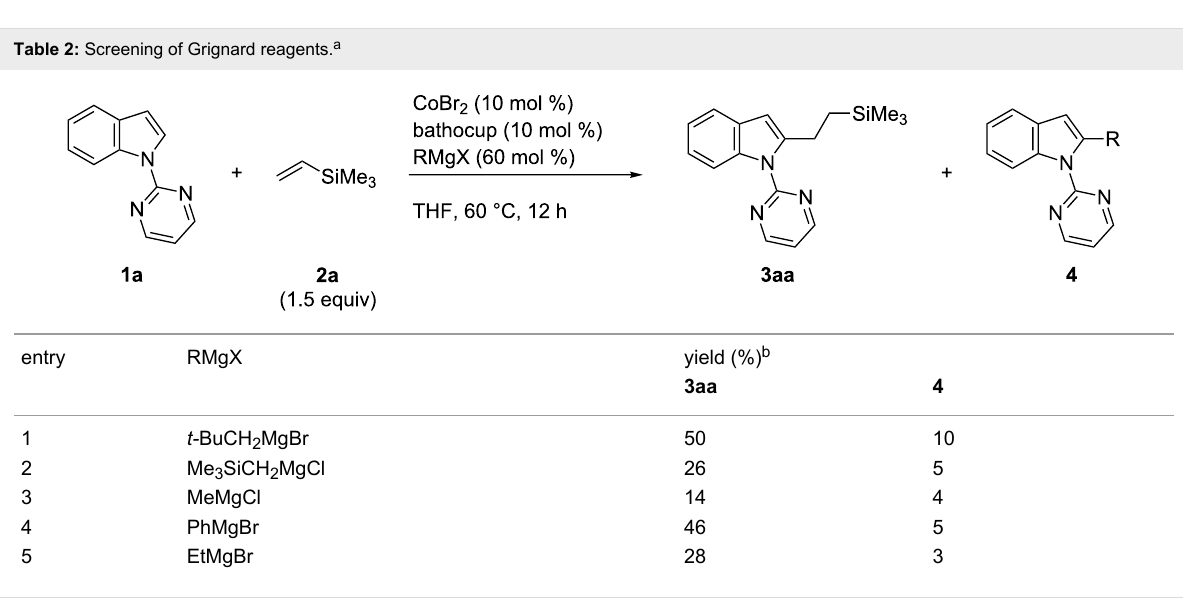
Table 2: Screening of Grignard reagents.